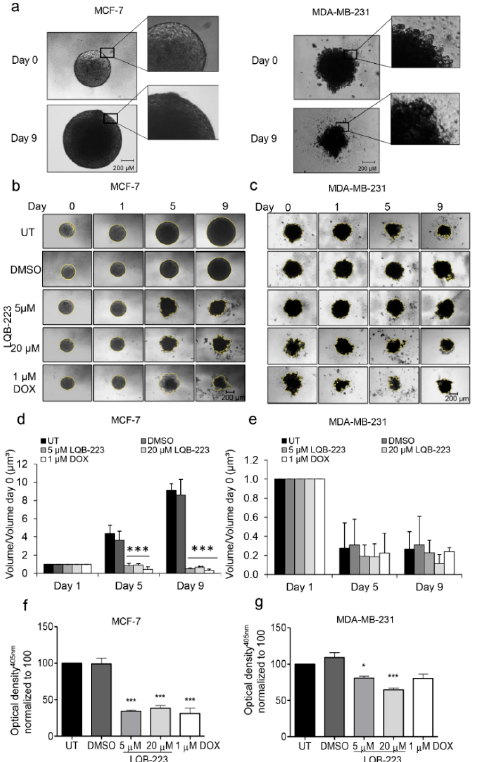
Figure 3. Cell viability and relative growth kinetics of 3D cultures after treatment with LQB-223 or DOX. ( a ) 3D structures of breast cancer cells were formed in non-adherent conditions. MCF-7 and MDA-MB-231 cells were seeded onto 96-well plates coated with 1.5% agarose and cultured for